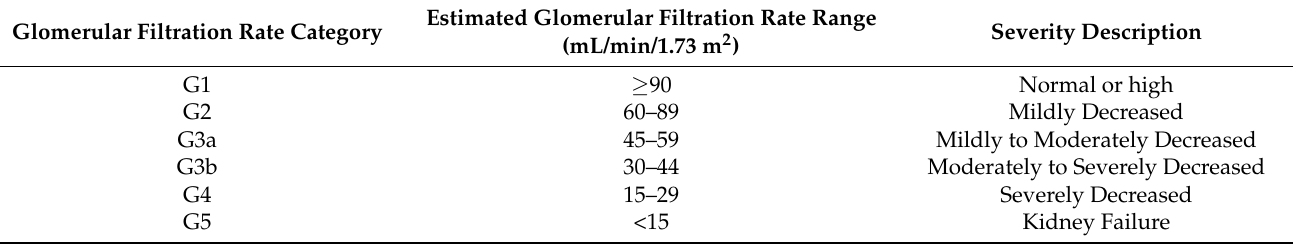
Table 2. Chronic kidney disease staging recommendation based on